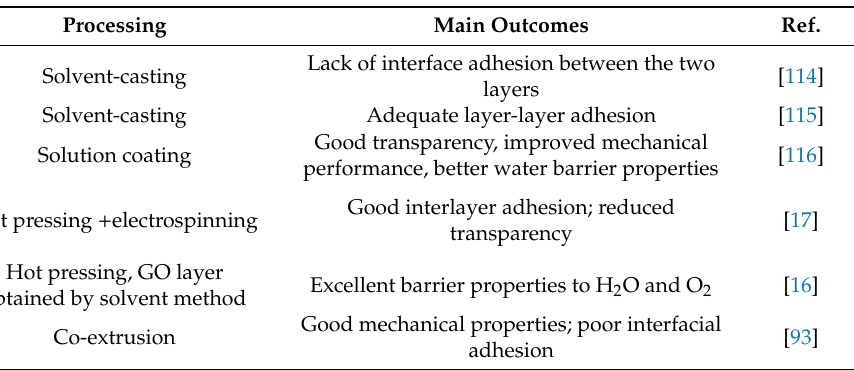
Table 1. Synoptic table of the discussed studies about multilayer